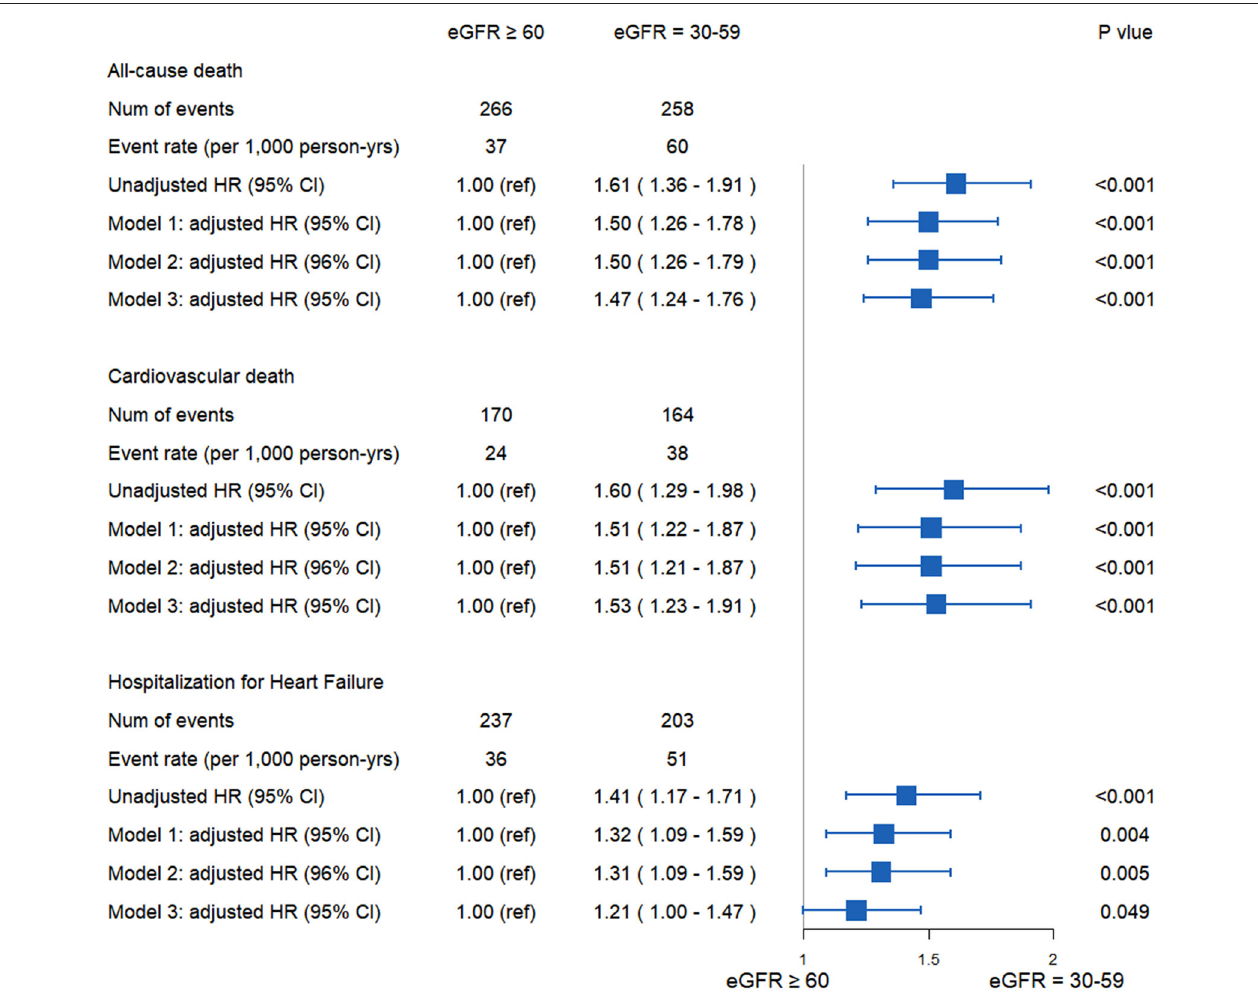
FIGURE 2 | All-cause death, cardiovascular death, and hospitalization for heart failure in HFpEF patients according eGFR. In model 1, the following parameters were adjusted: age, sex, race. In model 2, the following parameters were adjusted: age, sex, race, MI, previous hospitalization for heart failure, smoking status, alcohol intake, EF, HR, diuretics. In model 3, the following parameters were adjusted: the parameters of model 2 along with stroke, DM, HB, hypertension, atrial fibrillation, ICD, COPD, NYHA class, implanted pacemaker, dyslipidemia, beta blockers, ACE-I/ARB, CCB and randomization arm (spironolactone or placebo). CI, confidence interval; HFpEF, heart failure with preserved left ventricular ejection fraction; HR, hazard ratio; MI, myocardial infarction; EF, ejection fraction; HR, heart rate; DM, diabetes mellitus; HB, hemoglobin; ICD, implanted cardioverter-defibrillator; COPD, chronic obstructive pulmonary disease; NYHA, New York Heart Association;